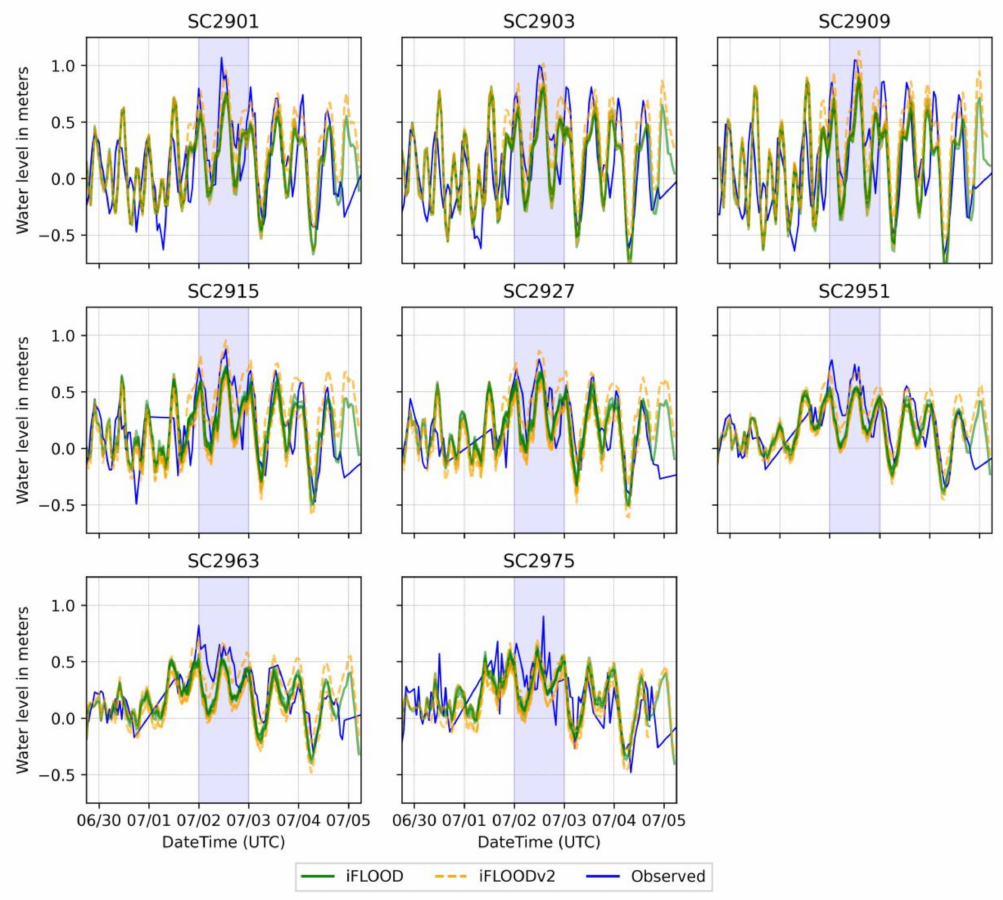
Figure 8. Time series plots of total water level forecasts compared against the observations, issued during the bomb cyclone between 28 June and 2 July 2020. The shaded gray vertical area shows the peak of the